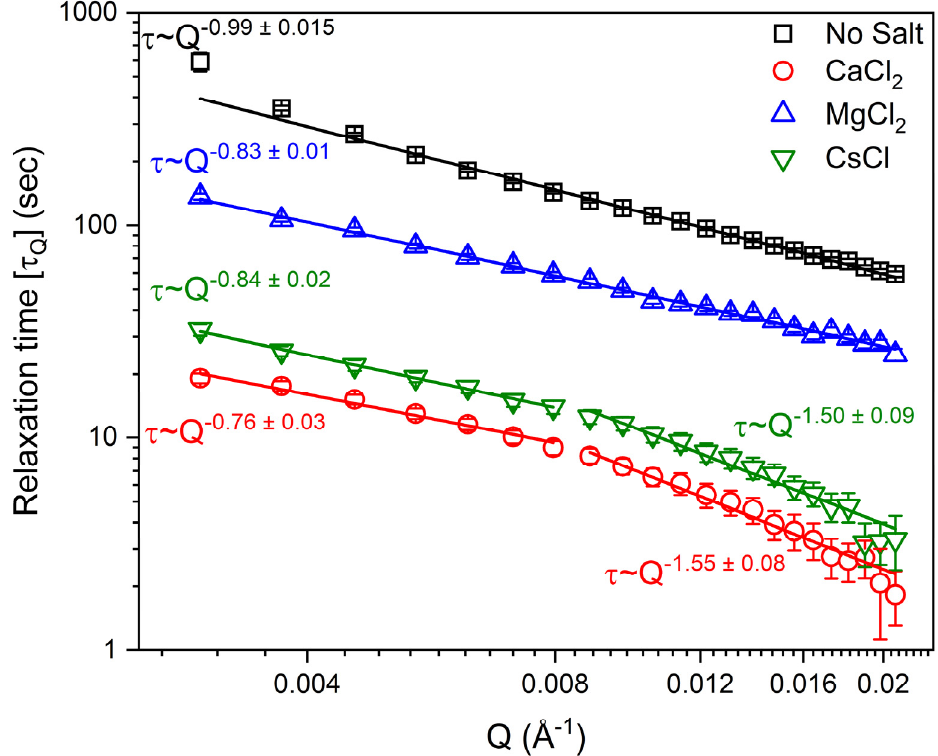
Figure 3. The relaxation time of 3 wt% aqueous laponite suspension prepared in 5 mM of CaCl 2 , MgCl 2 and CsCl, and without salt as a function of the wave vector, Q .